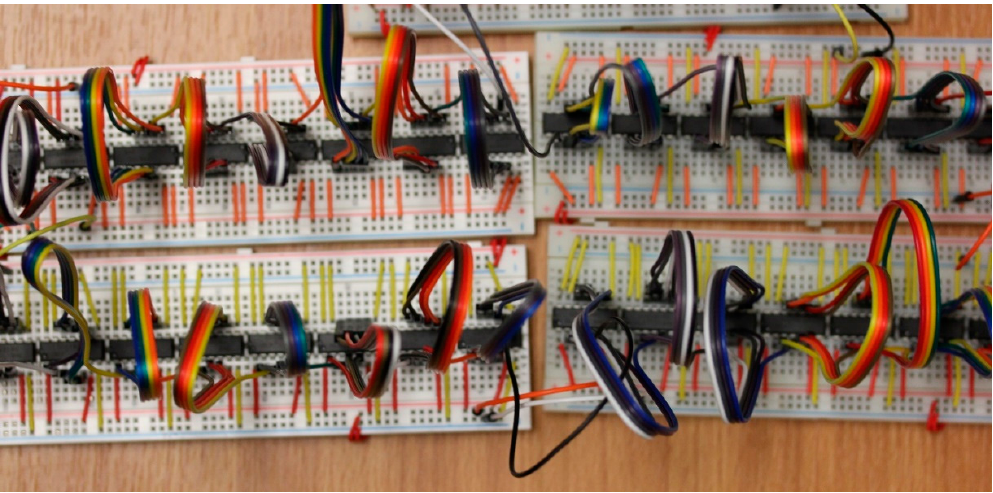
Figure A1. Hardware network implementation—top view.